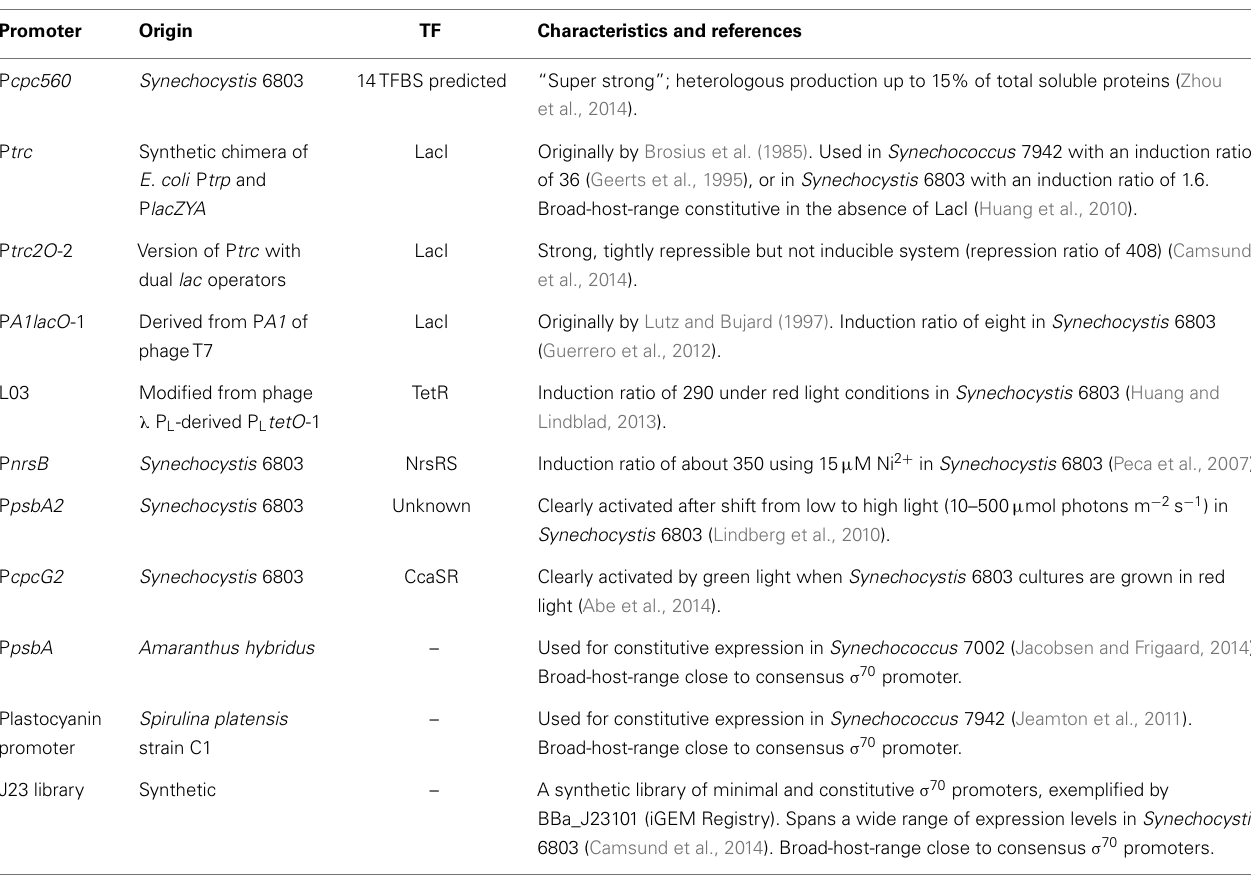
Table 1 | Selected promoters used for regulated and constitutive cyanobacterial expression